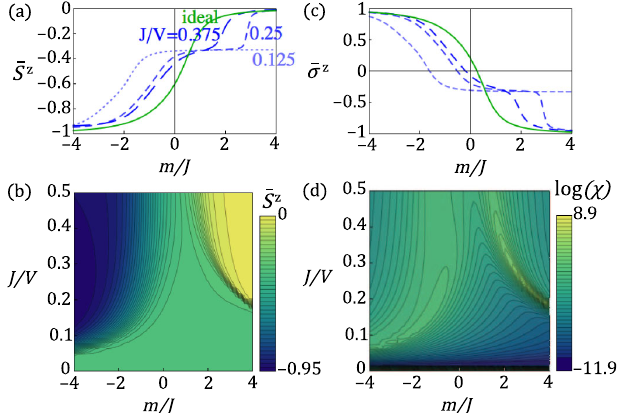
FIG. 6. Ground-state behavior of the microscopic model. (a)– (c) Similar to the ideal QLM, the system reaches (cid:1) S z (cid:10) (cid:1) 1 and (cid:1) (cid:5) z (cid:10) 1 for m=J !(cid:1)1 , and (cid:1) S z (cid:10) 0 and (cid:1) (cid:5) z (cid:10) (cid:1) 1 for m=J ! 1 . This denotes a transition from a parity- and charge-symmetric statetoaparity-andcharge-symmetrybreakingstate.Curvesfrom lighter to darker and shorter to longer dashes: J=V ¼ 0 : 125 , 0.25, 0.275. Solid line: Ideal QLM. The curves change their sign of curvature twice, indicating two phase transitions. (d) Similarly, the fidelity susceptibility (cid:10) ð m; J Þ has two peaks, suggesting two phase transitions. This behavior is in contrast to the ideal model, where (cid:10) ð m; J Þ has a single peak at m ¼ 0